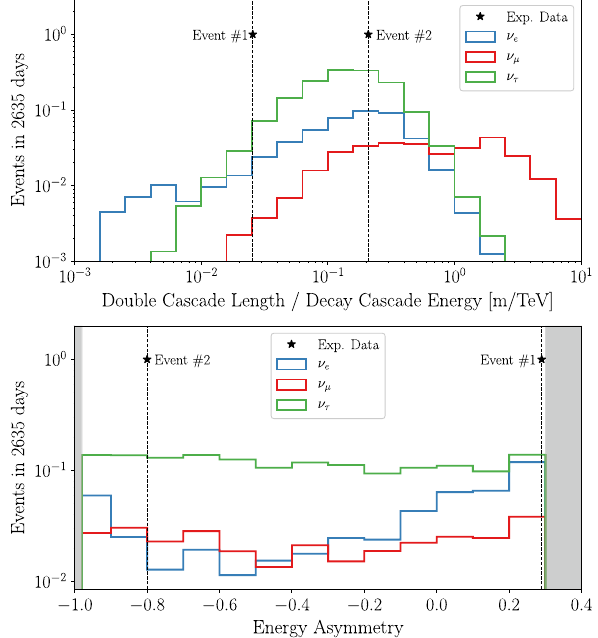
Fig. 5 Distribution of the ratio of double-cascade length to recon- structed decay-cascade energy (top), and of the reconstructed energy asymmetry (bottom) in the double-cascade subsample split by flavor content for the best-fit astrophysical and atmospheric spectra assuming flavor equipartition [19]. The values of the two double cascades are shown. Regions outside of the energy asymmetry values required for double cascades are marked in